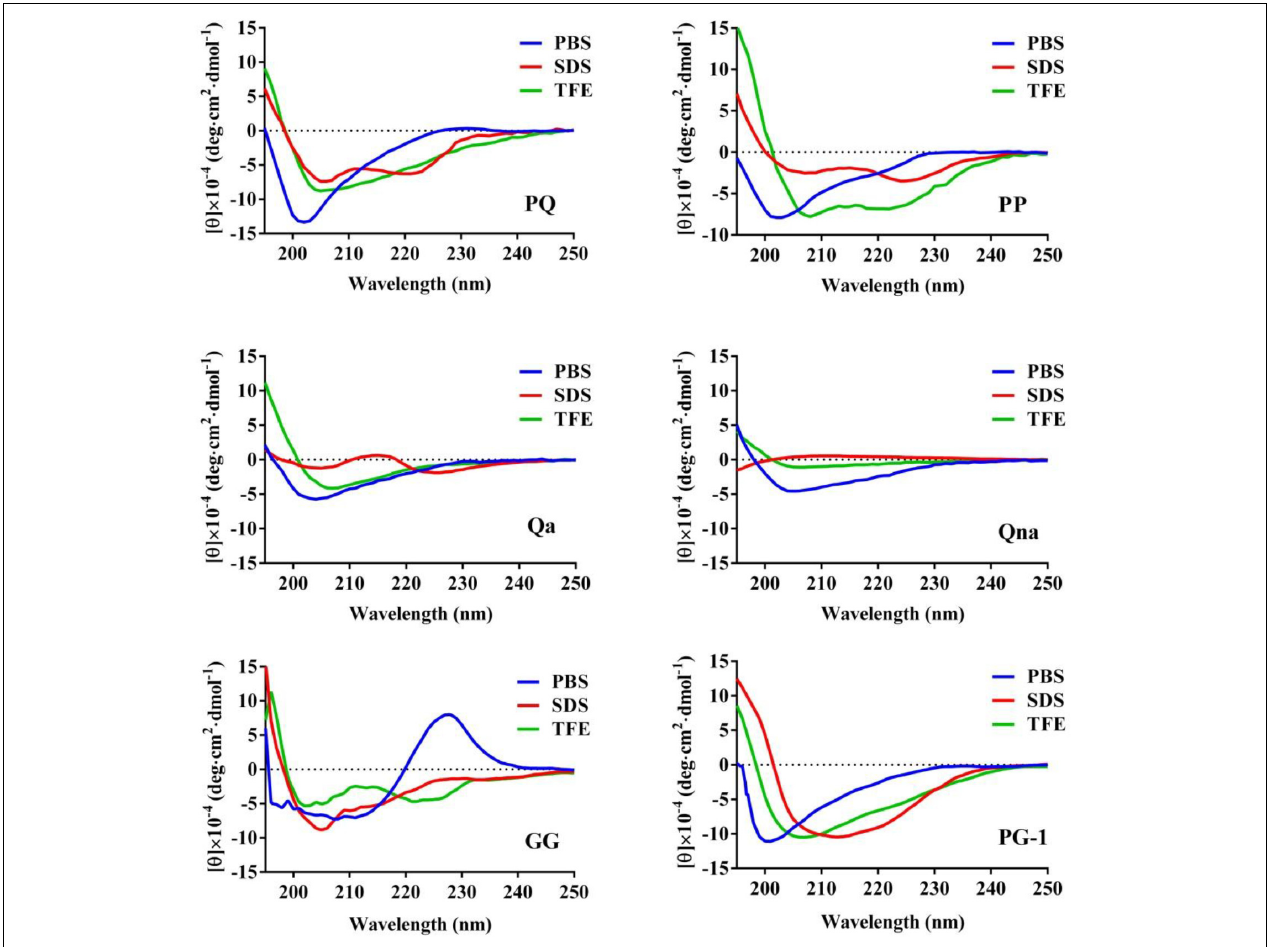
FIGURE 2 | The CD spectra of the peptides. The peptides were dissolved in 10 mM sodium phosphate buffer (pH 7.4), 50% TFE and 30 mM SDS. The mean residue ellipticity was plotted against wavelength. The values from three scans were averaged per sample, and the peptide concentrations were fixed at 150 µ M.